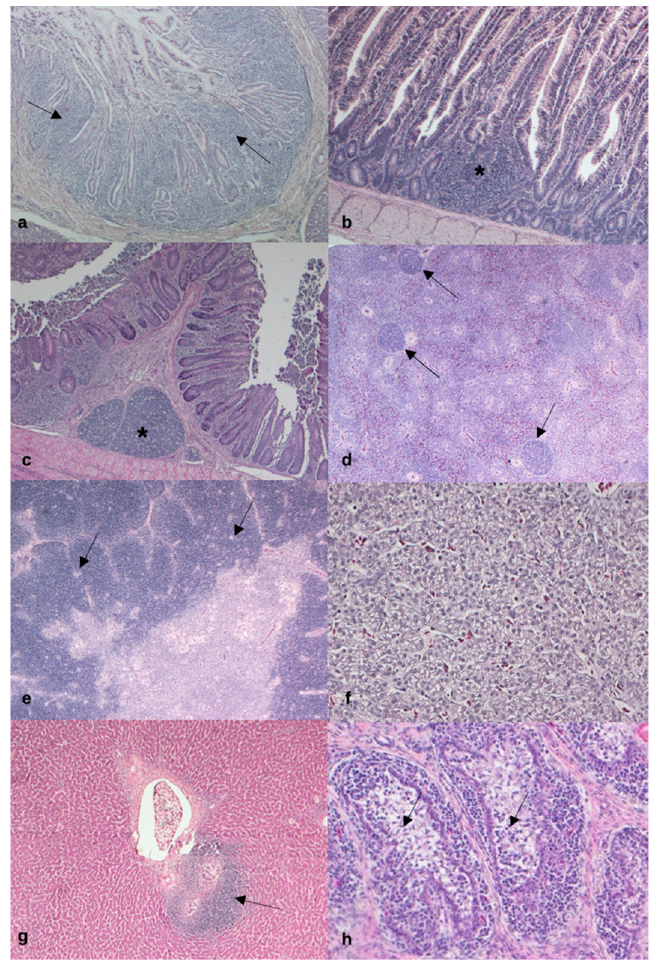
Figure 1. Main histopathological findings in the organs of the broiler chickens (n = 15/treatment). ( a ) Glandular stomach, mild lymphoplasmacytic infiltrates (black arrows), 5×, hematoxylin and eosin (HE). ( b ) Duodenum, mild lymphoplasmacytic infiltrates with lymphoid tissue hyperplasia (black asterisk), 5×, H-e. ( c ) Caecum, mild lymphoid tissue hyperplasia (black asterisk), 5×, H-e. ( d ) Mild white pulp hyperplasia (black arrows), 5×, H-e. ( e ) Thymus, mild cortical depletion (black arrows), 5×, H-e. ( f ) Liver, mild and multifocal vacuolar degeneration of the hepatocytes, 20×, H-e. ( g ) Liver, mild lymphoplasmacytic infiltrates (black arrow), 5×, H-e. ( h ) Bursa of Fabricius, mild follicular depletion (black arrows), 5×, H-e. Table 9. Effects of dietary BSF larvae fat inclusion on the histopathological scores of the broiler chickens (n = 15/treatment).